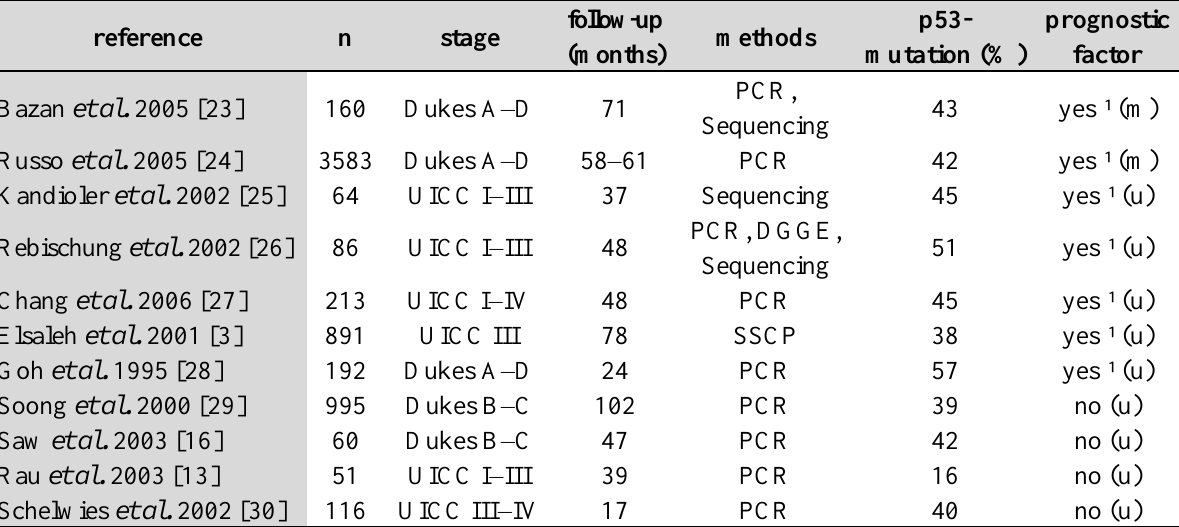
Table 1. Prognostic relevance of p53